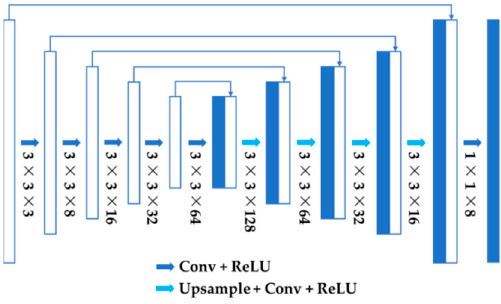
Figure 4. Architecture of the backbone for nuclear localization.